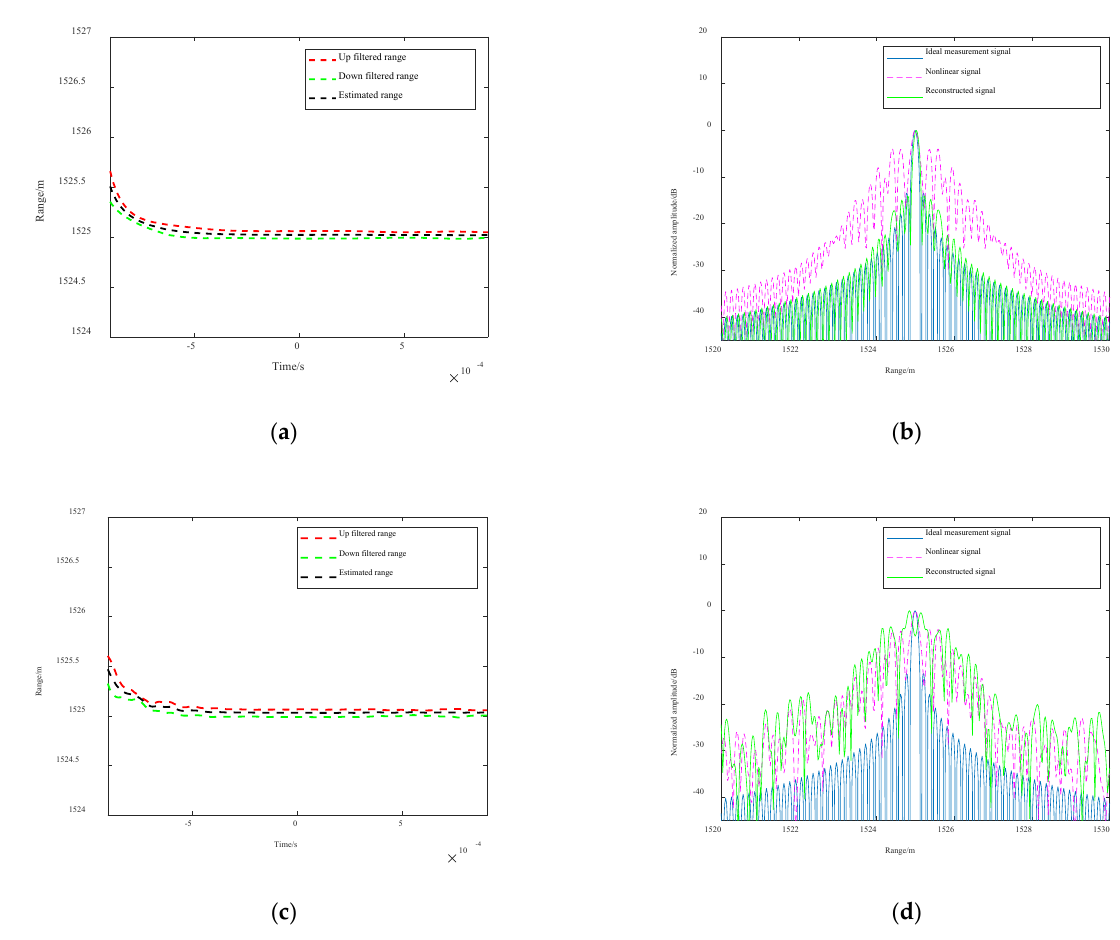
Figure 8. The estimated ranges of the proposed method ( a ) and the envelope detection method ( b ); the estimated ranges of the proposed method ( c ) and the envelope detection method ( d ) in the noisy environment with SNR of 5 dB.